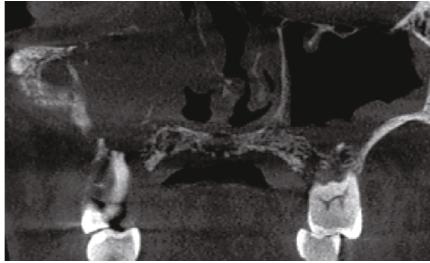
Figure 4: Coronal section of CBCT scan revealing destruction of walls of maxillary sinus along with involvement of nasopalatine canal.